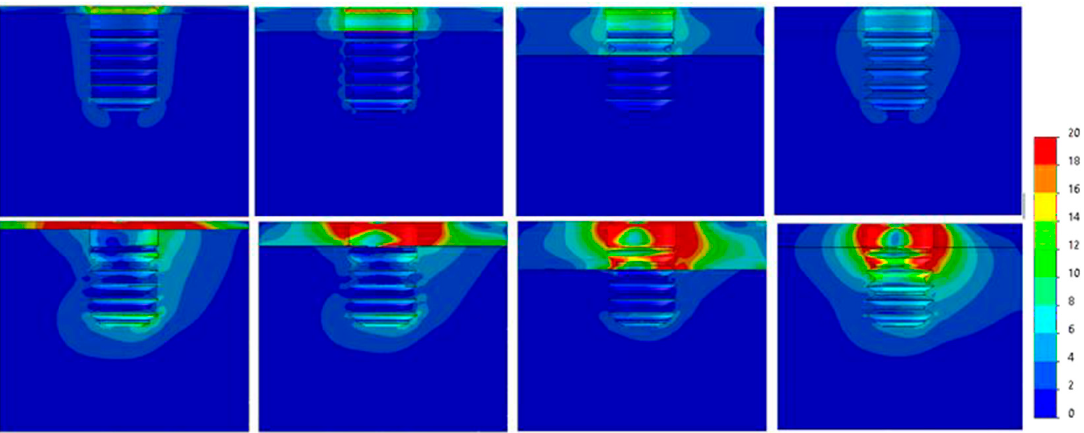
Figure 10. Von Mises equivalent stress (MPa) for Ø4 implant cases. Above, axial load, below, angled load. From left to right, Type IV, III, II, 0-I bone.